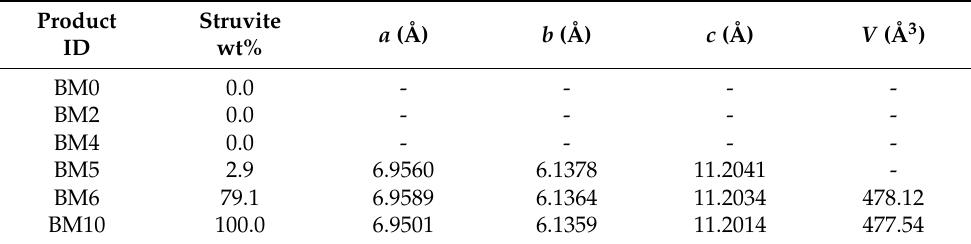
Table 3. Refined unit cell parameters for struvite from XRD data using the Rietveld approach